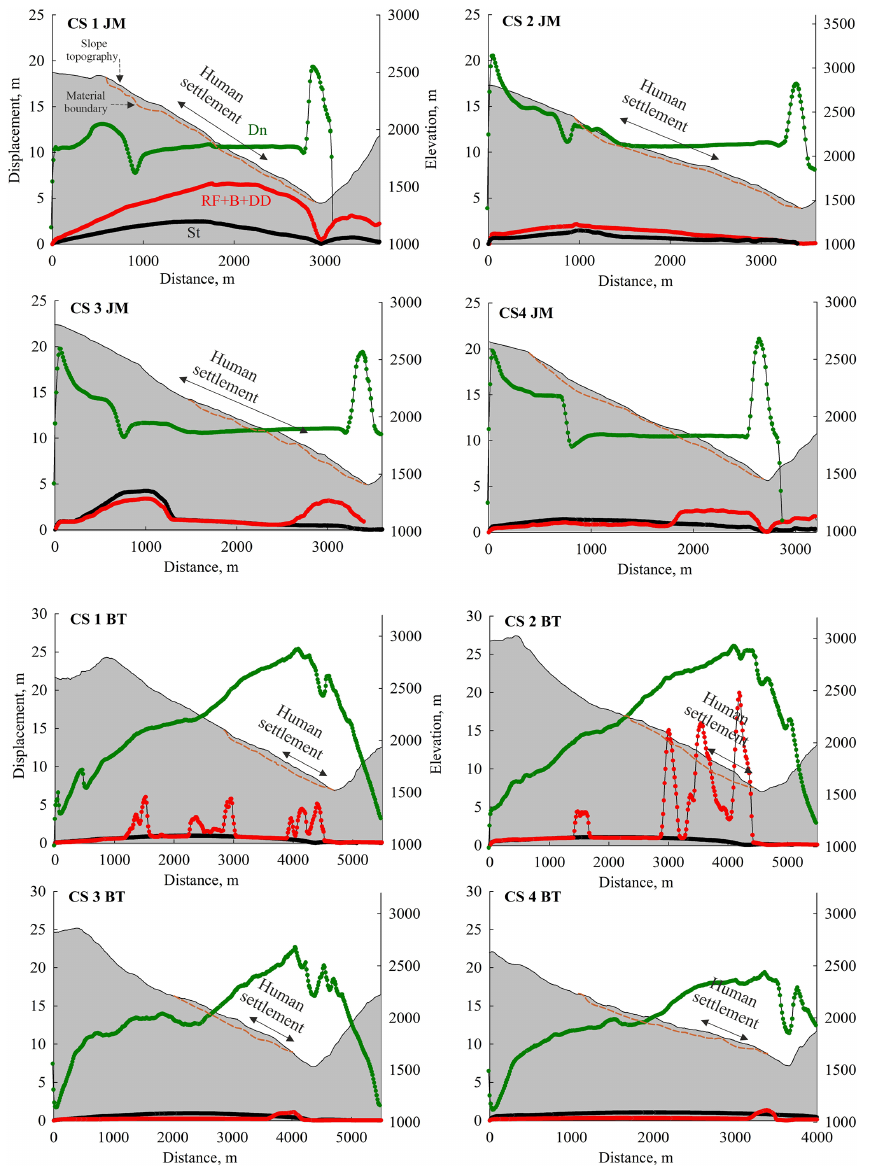
Figure 3. Results of the slope stability evaluation. CS 1 JM to CS 4 JM refer to Joshimath slope sections, whereas CS 1 BT to CS 4 BT refer to slope sections of the Bhatwari hillslope. Dn, RF, B, DD, and St refer to dynamic, rainfall infiltration, building load, domestic discharge, and static load,